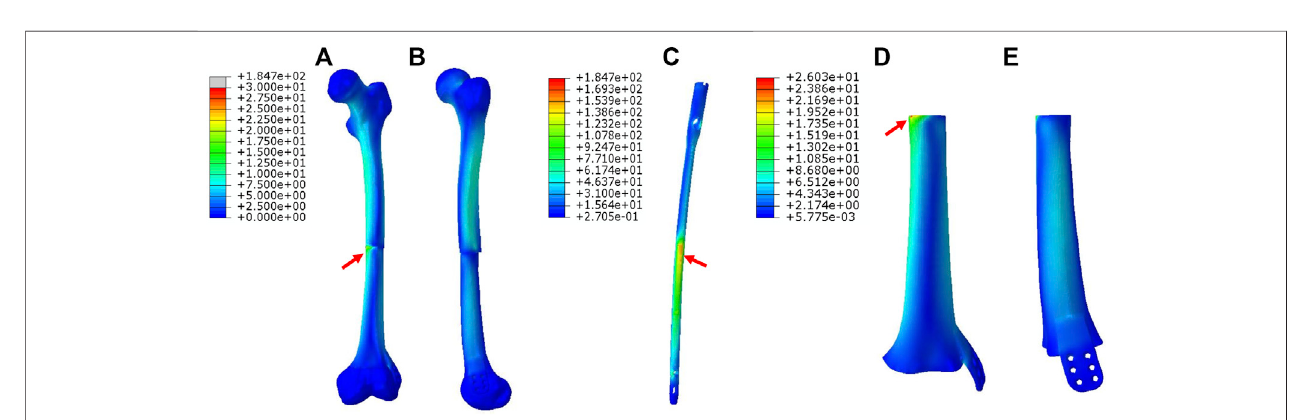
FIGURE 4 | Von Mises stress distribution in Mode II fi xation pattern, the red arrows direct the maximum stress concentration.